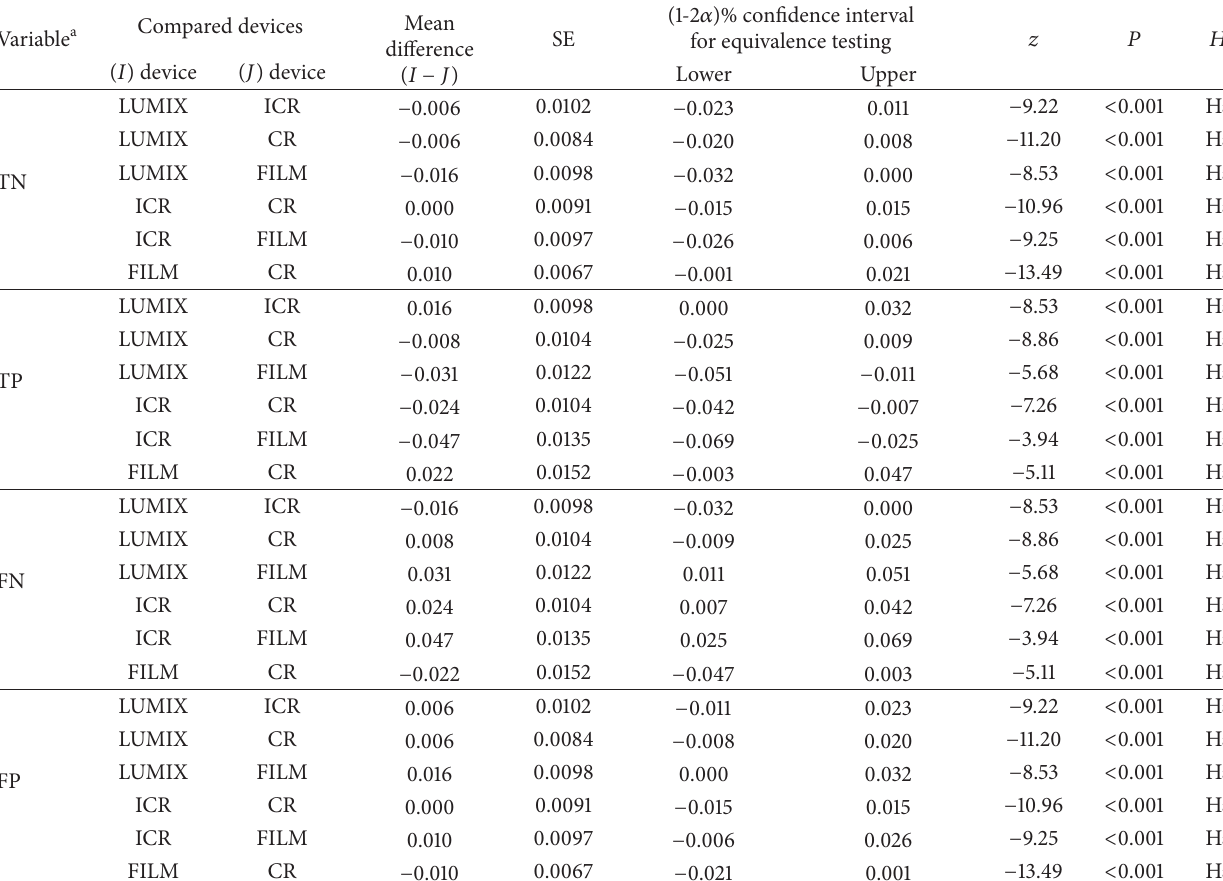
Table 4: Equivalence tests ( 𝛿 = 0.1 ) for TN, TP, FN, and FP by paired devices. Variable